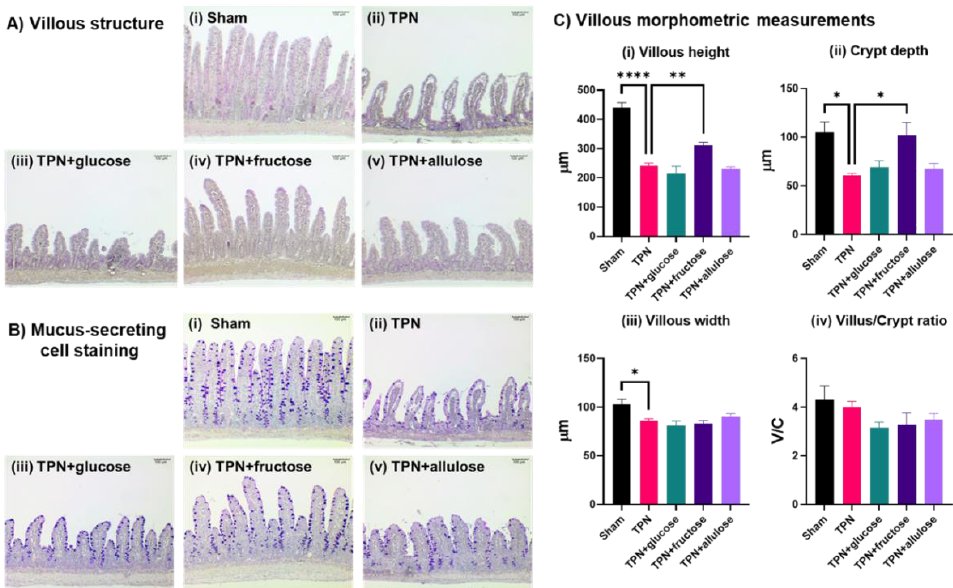
Figure 5. Villous structure and number of mucus-positive cells. ( A ): villous structure of ( i ) sham, ( ii ) TPN, ( iii ) TPN + glucose, ( iv ) TPN + fructose and ( v ) TPN + allulose rats. ( B ): mucus-secreting